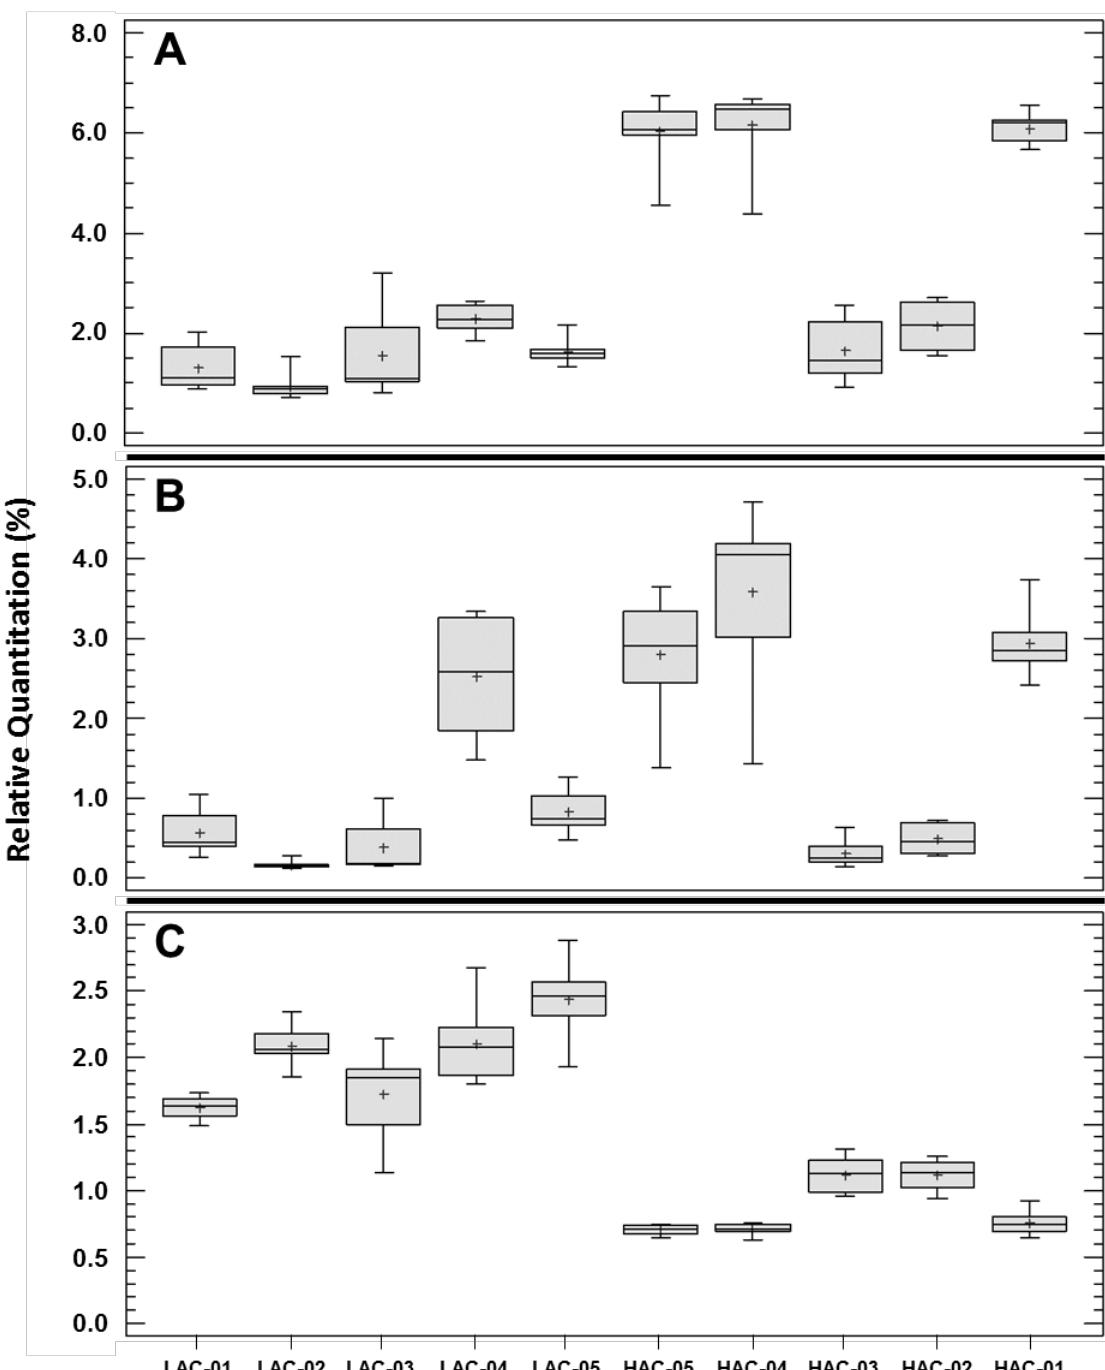
Figure 3. Relative quantitation of 3 phospholipids in clinical strains of Pseudomonas aeruginosa exhibiting extreme and opposite attachment capacities. Among the 28 phospholipids quantified through the 11 P. aeruginosa strains selected for this study, three phosphatidylethanolamine species, PE 16:0-17:1 ( A ); PE 17:1-19:1 ( B ) and PE 18:1-18:1 ( C ), presented